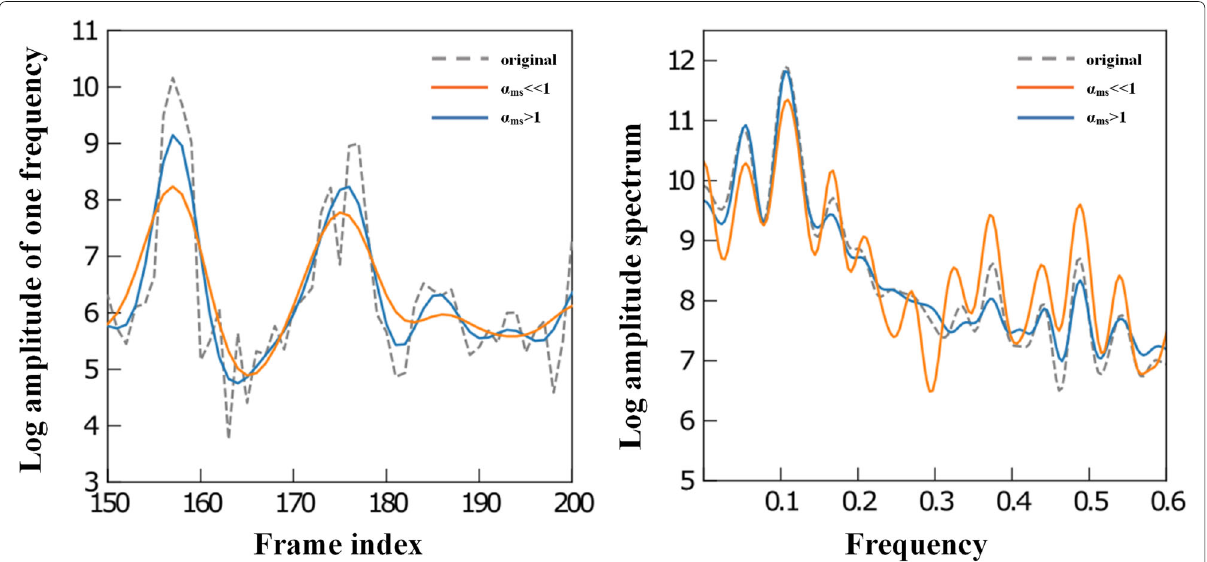
Fig. 5 Examples of modulation spectrum smoothing: temporal smoothing of amplitudes (left) and spectral changes before and after smoothing (right)